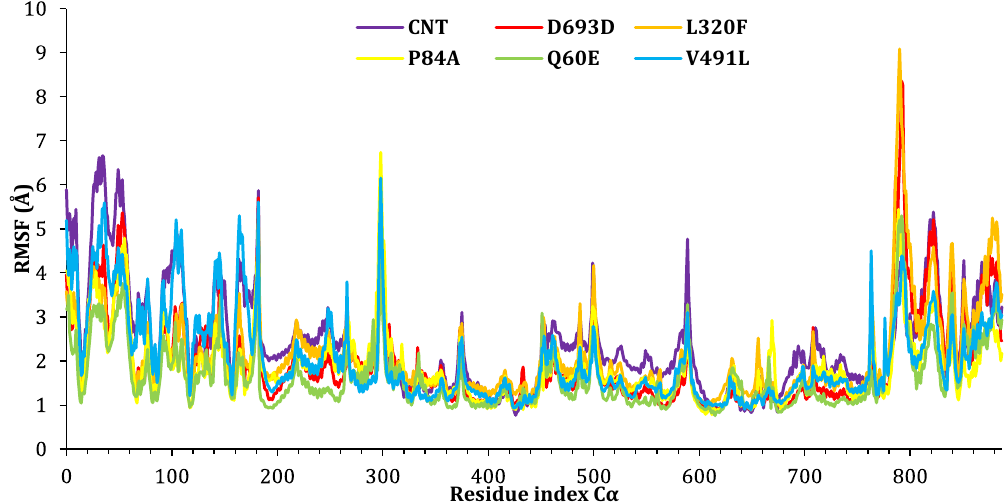
Figure 10. The RMSF of the complexes during simulation trajectories.